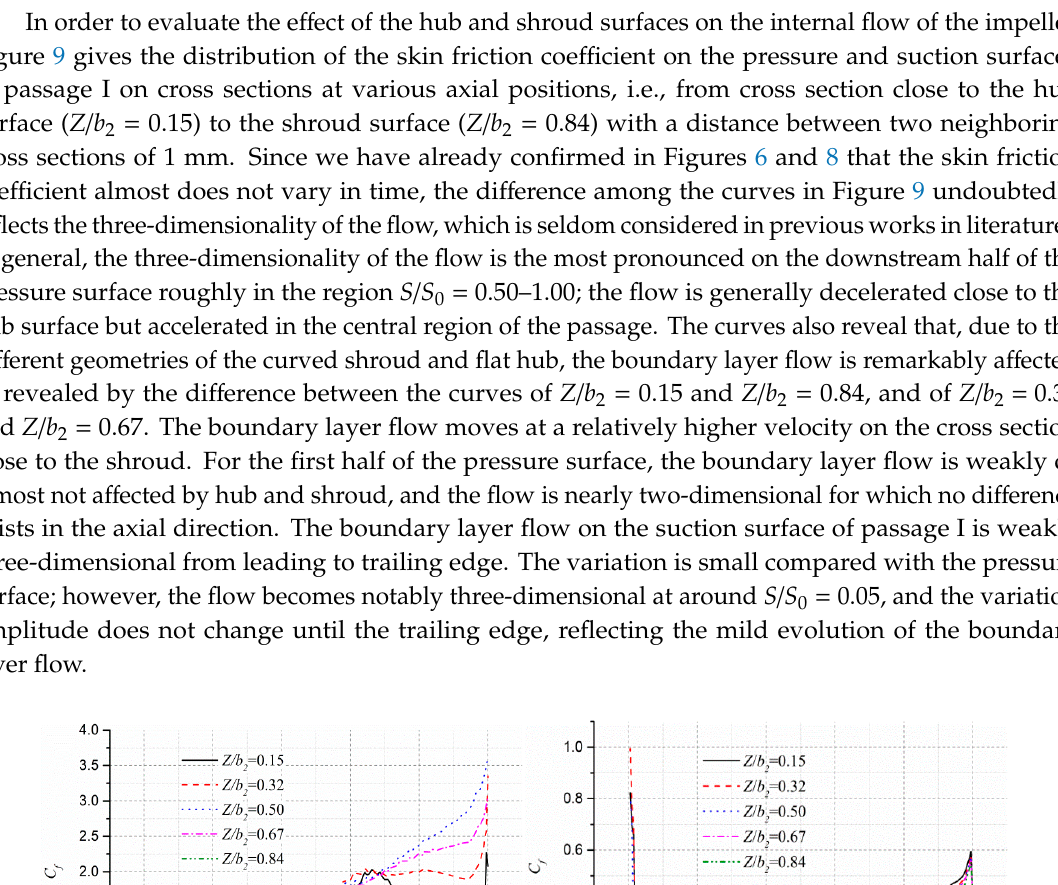
Figure 8. Distribution of the skin friction coefficient on the blade surface for the Z / b 2 = 0.5 cross section: ( a ) pressure surface and ( b ) suction surface. ( a ) pressure surface and ( b ) suction surface.